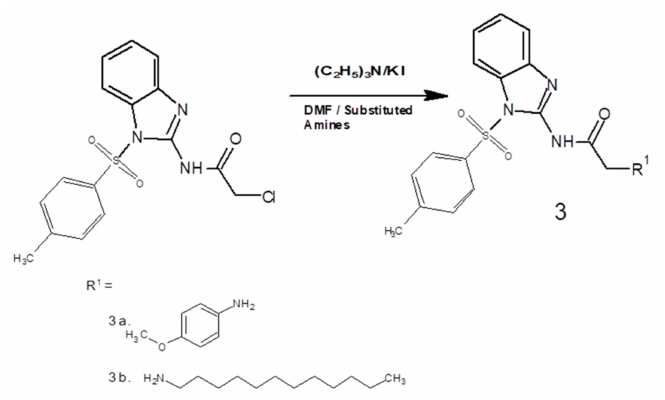
Figure 1. Generalschemetosynthesizenovelbenzimidazoleacetamidederivatives.